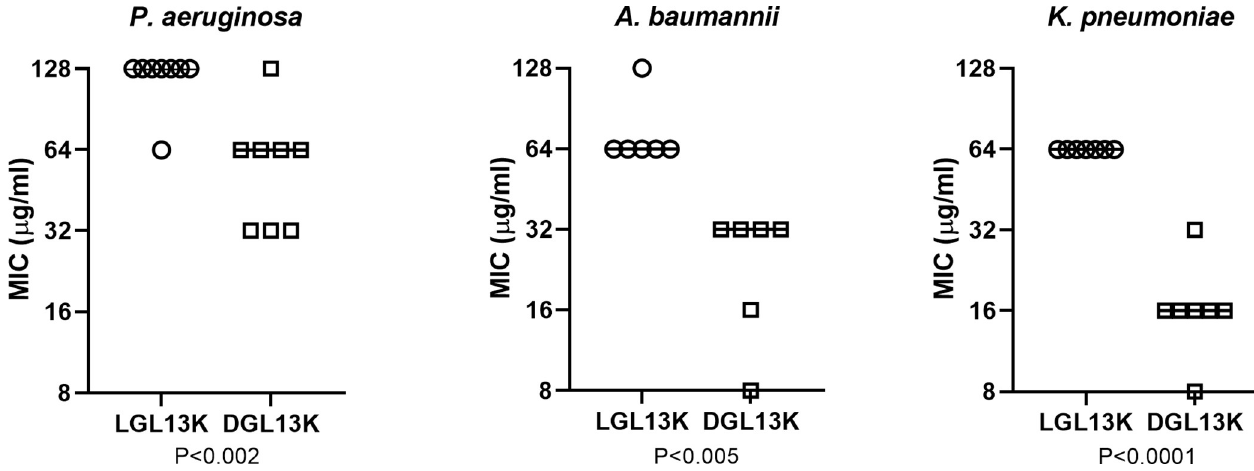
Fig 1. Comparison of MIC values for different strains of P . aeruginosa , A . baumannii and K . pneumoniae treated with LGL13K or DGL13K. For each species listed in Table 1, the MIC of the two peptide enantiomers were compared by paired student’s t-test. P-values are indicated. Lines represent the median MIC of each